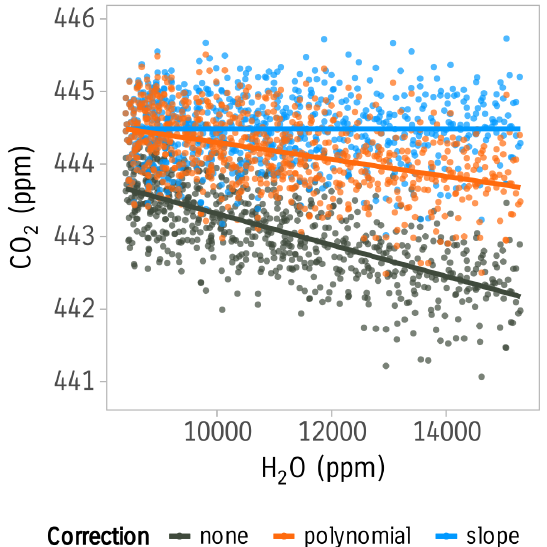
Figure 7. Effect of water correction on the measured CO 2 concen- tration using the LGR FGGA-24r-EP instrument. Points represent measured CO 2 by the gas analyzer when air with constant CO 2 concentration and varying H 2 O concentration was supplied. Lines represent linear regression fits. Red-colored points and the red line represent CO 2 measurements after applying the polynomial correc- tion (Hiller et al., 2012; Rella, 2010). In blue are the CO 2 mea- surements after applying our slope adjustment correction to remove additional cross-sensitivity to